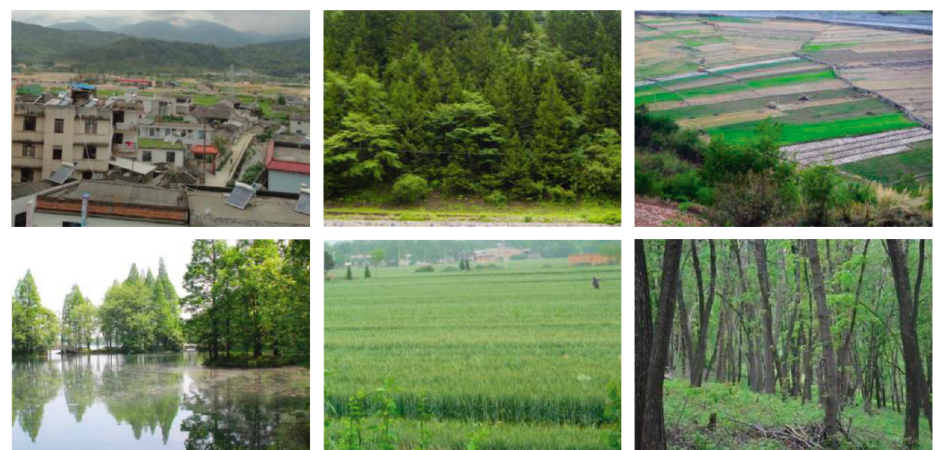
Figure 3: Marking points of the sampling route in the field.